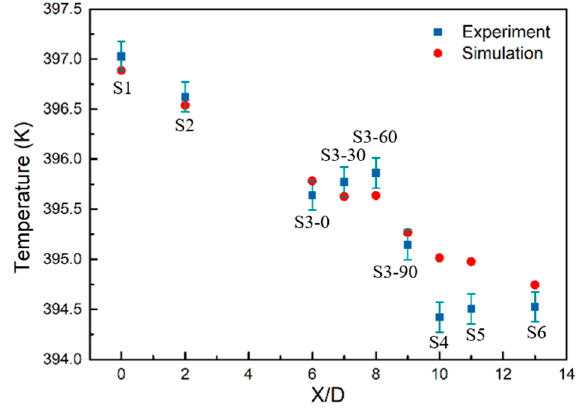
Figure 7. Average temperatures in streamwise direction of straight pipe.